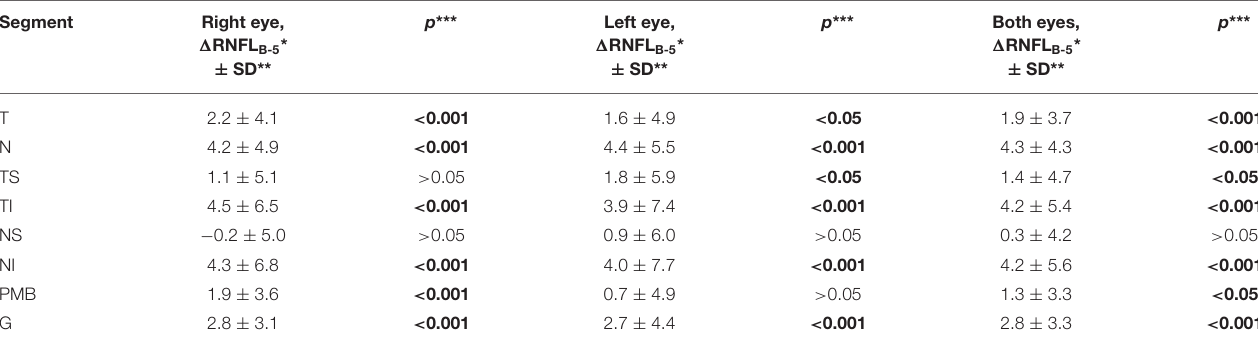
TABLE 3 | Changes in RNFL thicknesses in patients with MS at the baseline and follow-up assessments. Segment